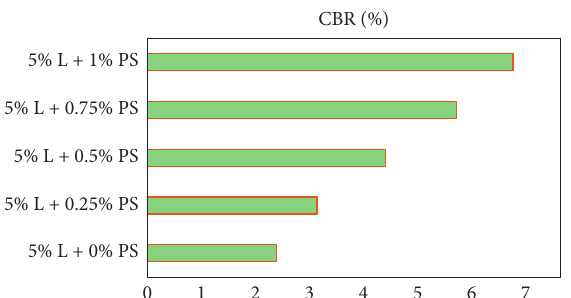
Figure 7: Variation of CBR values with proportions of plastic waste strips.